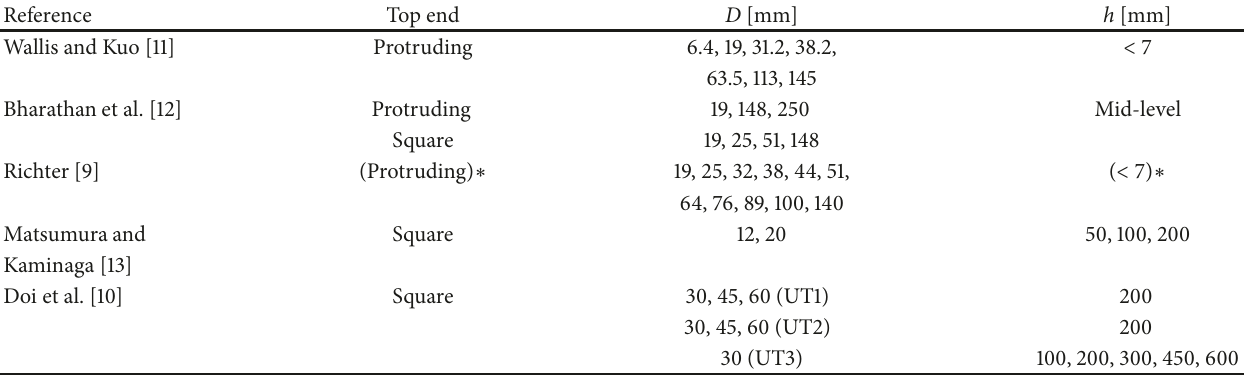
Table 2: Experimental conditions ( D , diameter; h , water level; ∗ our judgement of the condition).